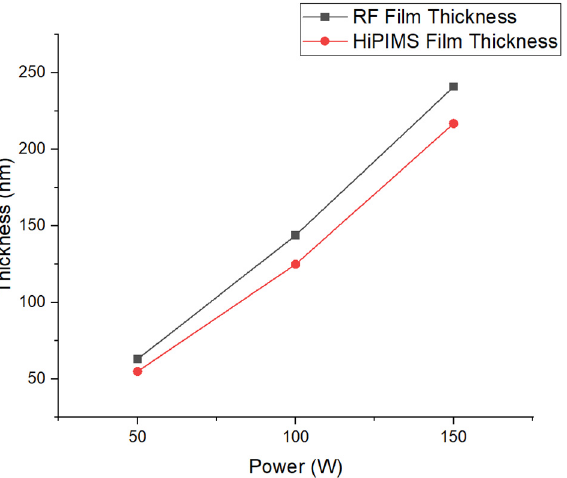
Figure 1. Plot of film thicknesses vs. average power for both RF and HiPIMS depositions. Consistently, the RF sputtered thin film grew faster than the film grown by HiPIMS.